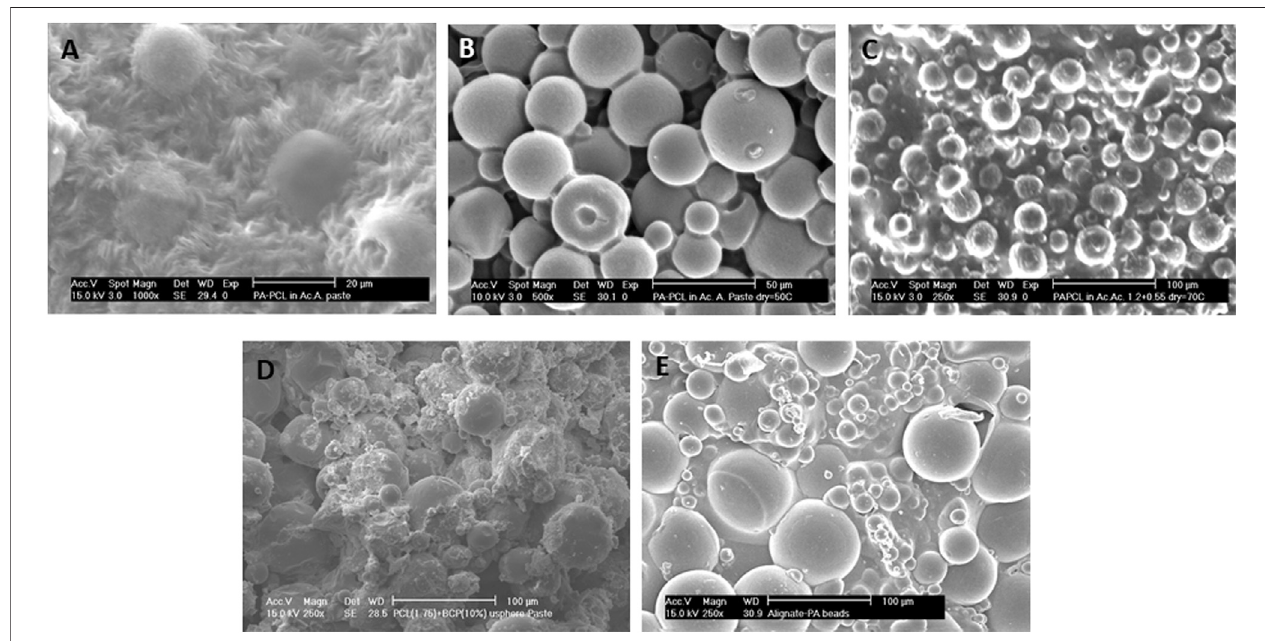
FIGURE 3 | Different surface morphologies were obtained when PCL solutions were used as the second polymeric phase and dried at different temperatures: (A) room temperature, (B) just below PCL melting temperature at 50 ° C, or (C) just above PCL melting temperature at 70 ° C. (A,C) Microspheres are entrapped within the PCL matrix or (B) loosely bound to each other via a PCL thin neck layer. (D) BCP-containing 300PEOT55PBT45-PCL pastes (70 ° C). (E) Alternatively, PCL was substituted as the second polymeric phase, and 300PEOT55PBT45-alginate pastes were created. Scale bars: (A) 20 μ m; (B) 50 μ m; (C – E) 100